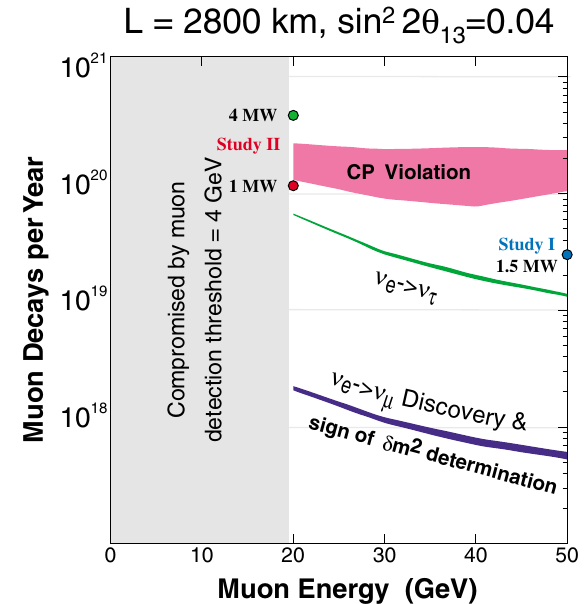
FIG. 1. (Color) Muon decays in a straight section per 10 7 s vs muon energy, with fluxes required for different physics searches assuming a 50 kT detector. Simulated performance of the two studies is